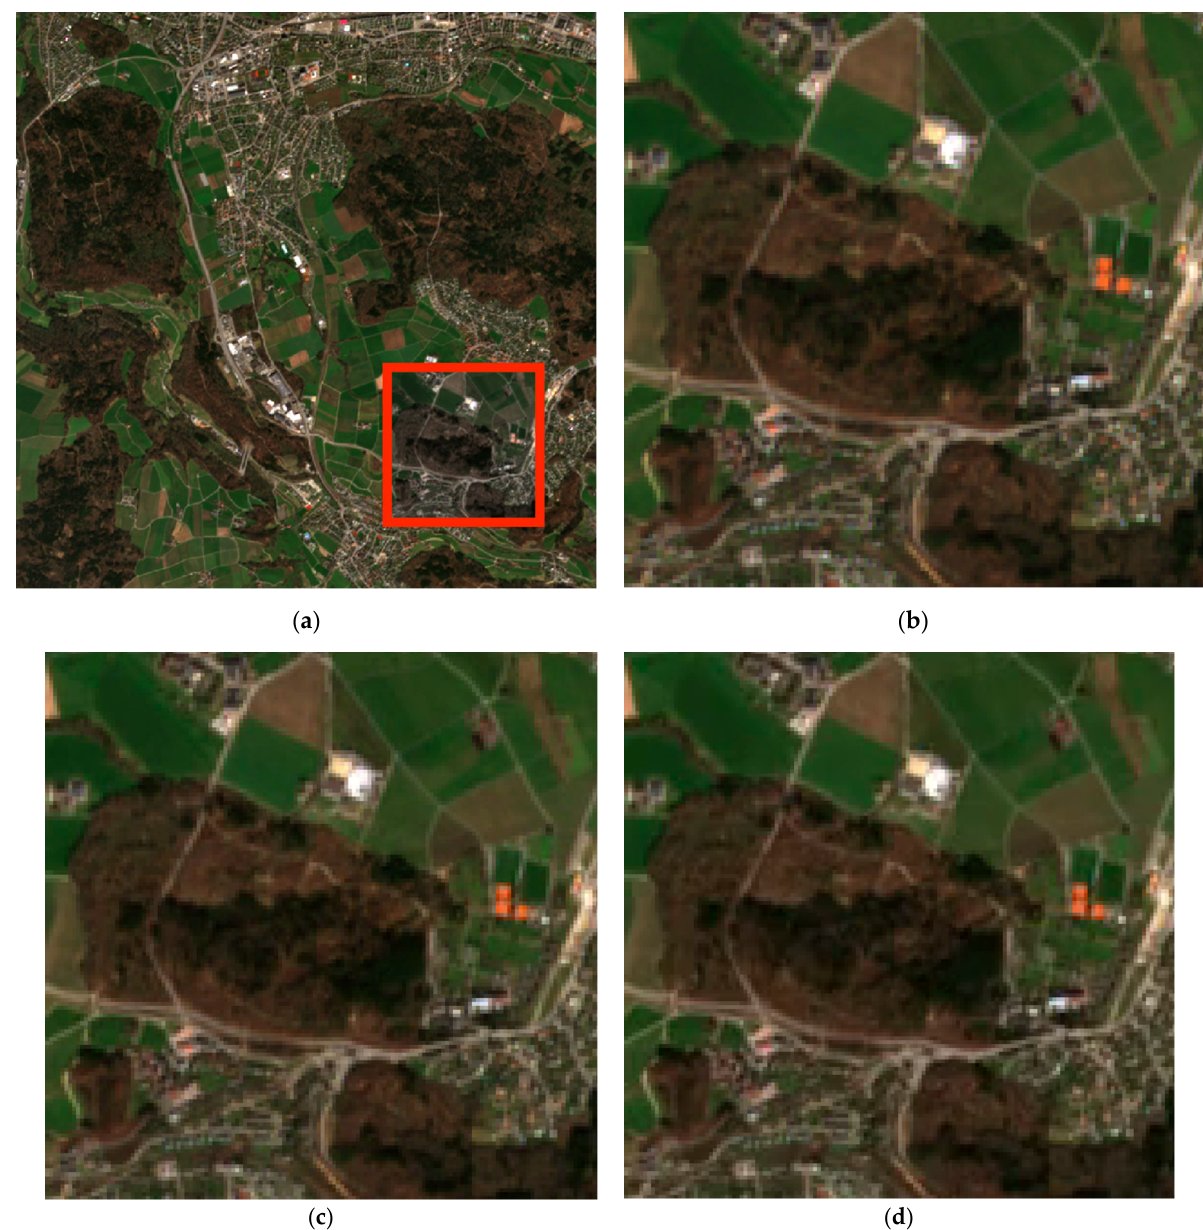
Figure 6. Side ‐ by ‐ side visual comparison between highly zoomed regions of the first image layer (layer 01, initially cropped from T32TMT_20180402T102021_TCI_10m) at different quality levels: ( a ) location of the zoomed region inside the 45th tile of layer 01. ( b ) Zoomed region from lossless CORE version encoded with CRF 0—identical with original data; ( c ) zoomed region from CORE version with CRF 18; ( d ) zoomed region from CORE version with CRF 23.